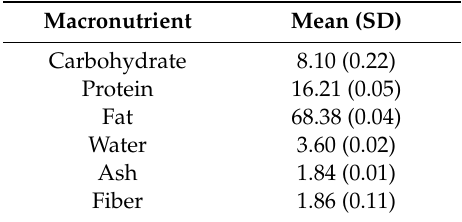
Table 1. Mean macronutrient content of Serbian